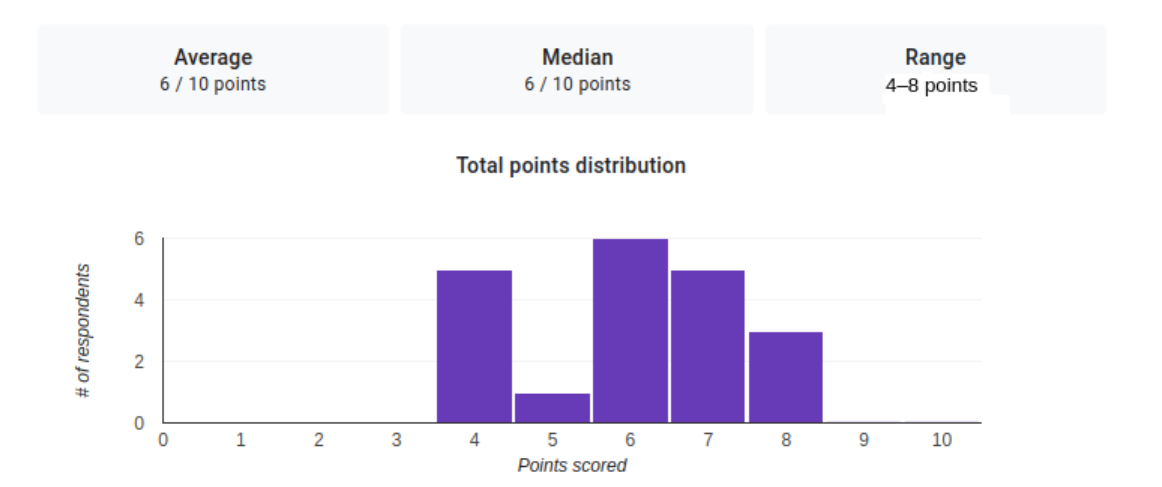
Figure 13. The distribution of the scores obtained by the 20 subjects for the correct identification of the actions. Table 10. Comparative performances from the perspective of computability (processing speed and number of